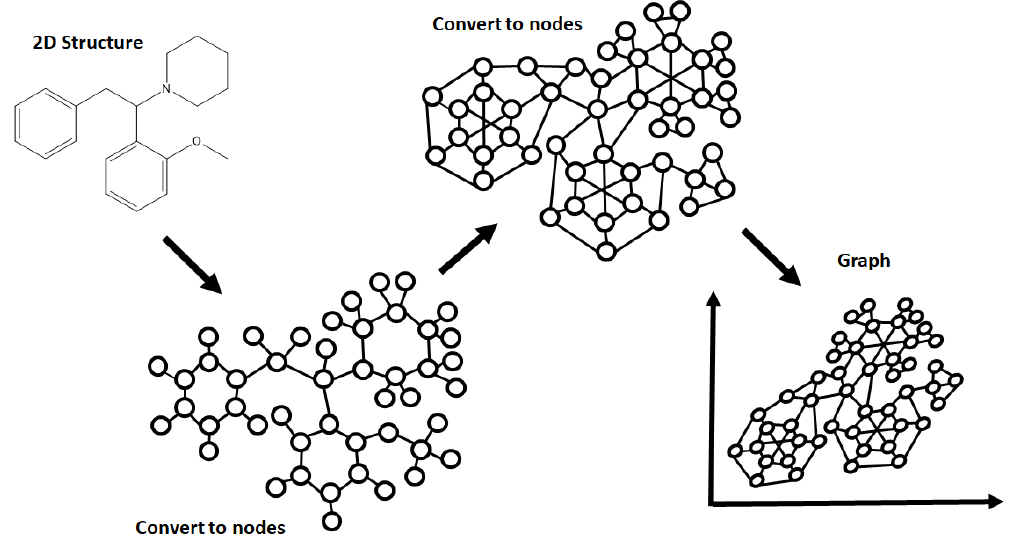
Figure 2. The concept behind the graph convolution model, stemming from the conversion of a model compound (2- methoxphenidine) into nodes that are ready for convolution and graphing.